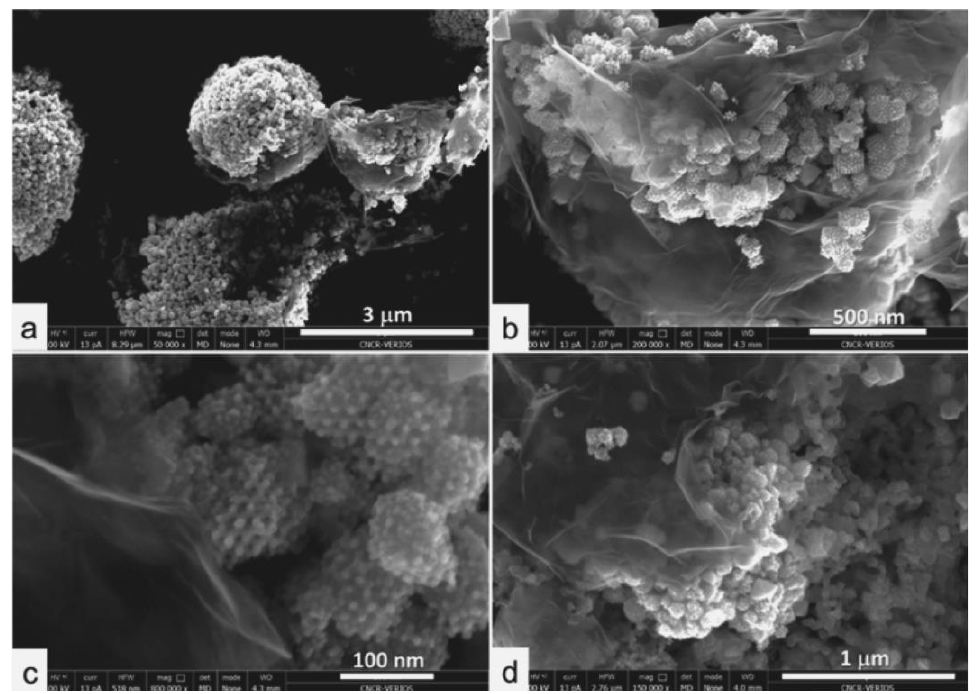
Figure 8. High resolution SEM captions of ( a – d ) CuO-NiO nanoparticles enwrapped within exfoliated graphene nanosheets. Reproduced, adapted and reprinted with permission from Reference [131] .